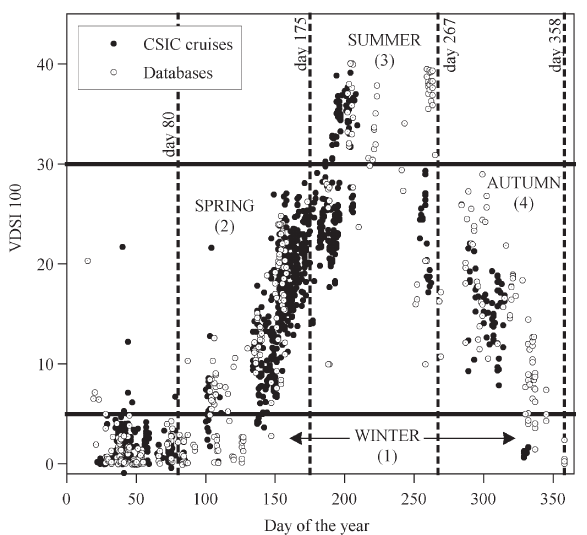
Fig . 2. – Variation throughout the year of the vertical stratification index at 100 m. CSIC Cruises, data from the cruises gathered for this study; Databases, data from MEDATLAS and MATER databases. Between brackets, stratification index that represents each season of the